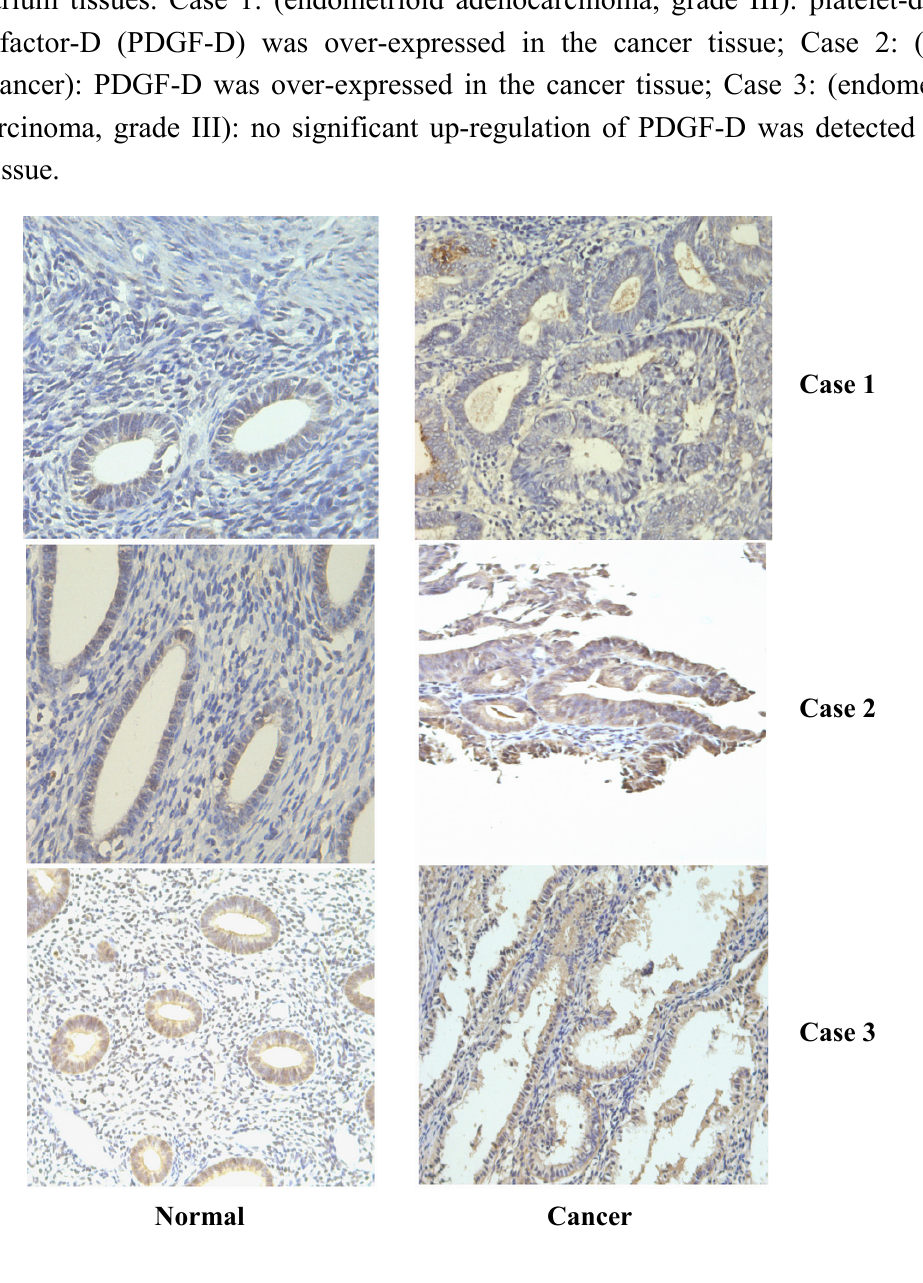
endometrium tissues. Case 1: (endometrioid adenocarcinoma, grade III):